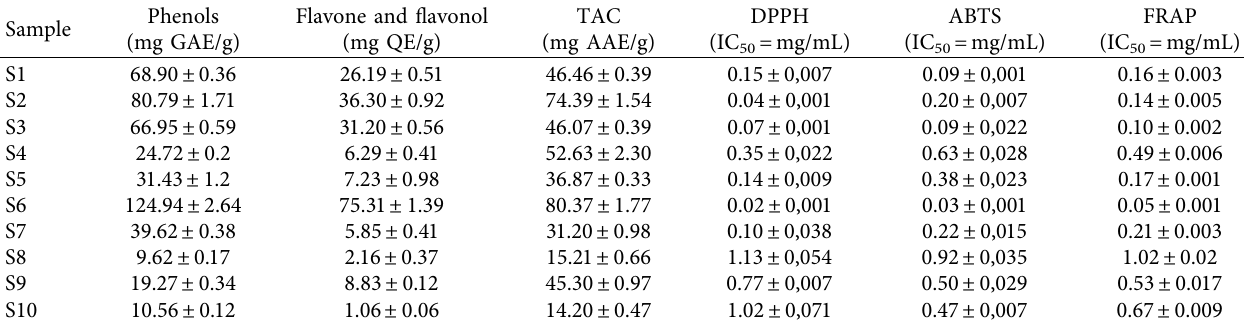
Table 4: Bioactive compounds estimations and antioxidant activities (DPPH, ABTS, and FRAP) of propolis samples. Sample